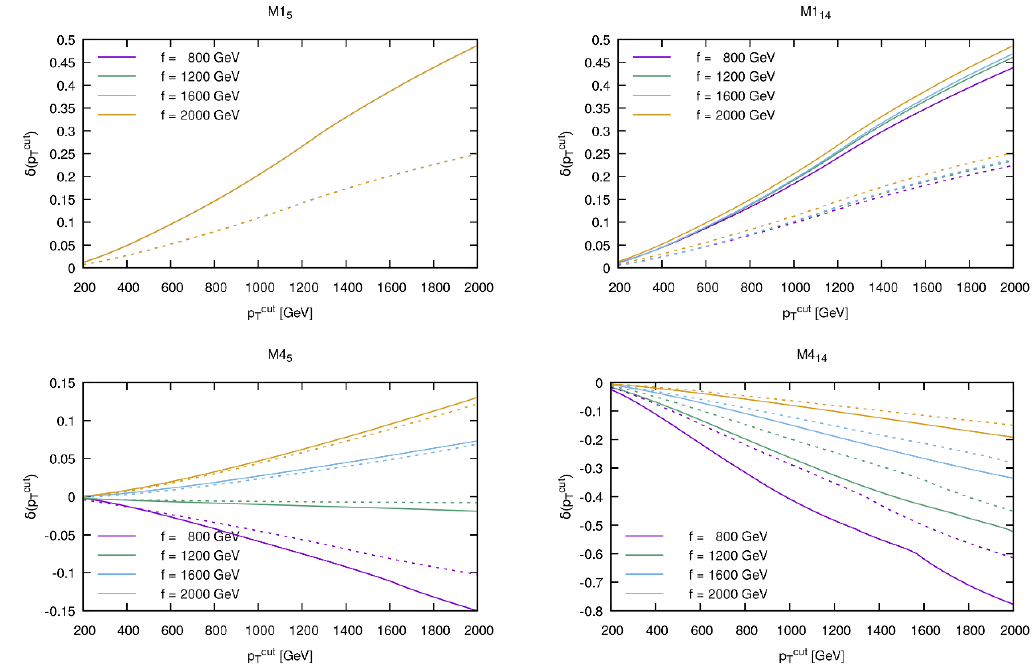
Figure 19 . The distribution (cid:14) ( p cut section